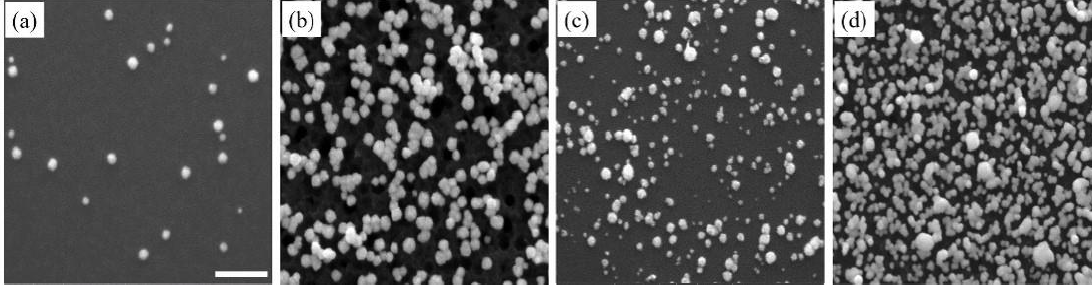
Figure 4. SEM images of Pt nanostructures deposited on Si substrate after the ( a ) first and ( b ) tenth deposition cycles in the presence of SDS surfactant, and ( c ) first and ( d ) tenth deposition cycles with CTAB surfactant. The scale bar is 500 nm.